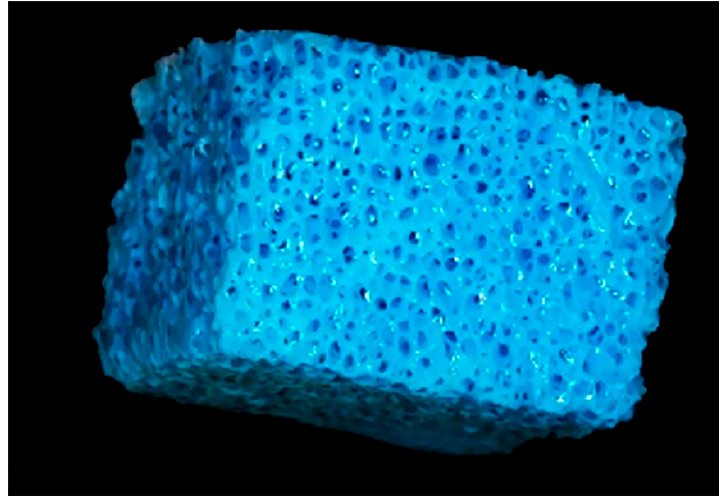
Figure A2. Wettability of the inorganic xenogenous bone (control group) immediately after being extracted from the solution. No drop formation was evident.